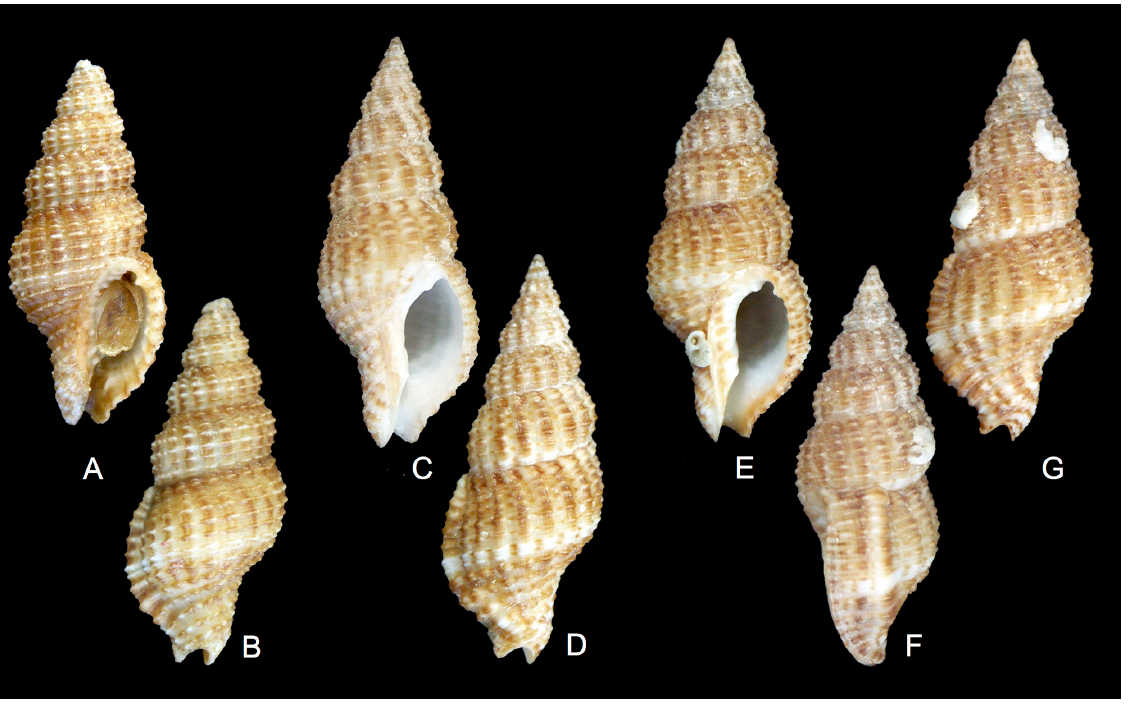
Fig. 8. Sinetectula shepstonensis (Tomlin, 1926) gen. et comb. nov. A–B . Specimen from Oman, Mirbat, depth 30 m, 24.9 mm long (KF 8048). C–D . Specimen from off Somalia, deep water, 25.0 mm long (KF 2208). E–G . Specimen with same collection data as for preceding, 27.3 mm long (KF